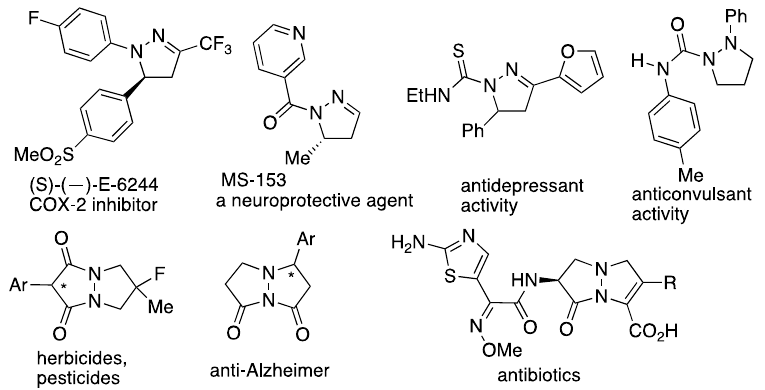
Figure 2. Pyrazolines and pyrazolidines as subunits of bioactive compounds and drugs.